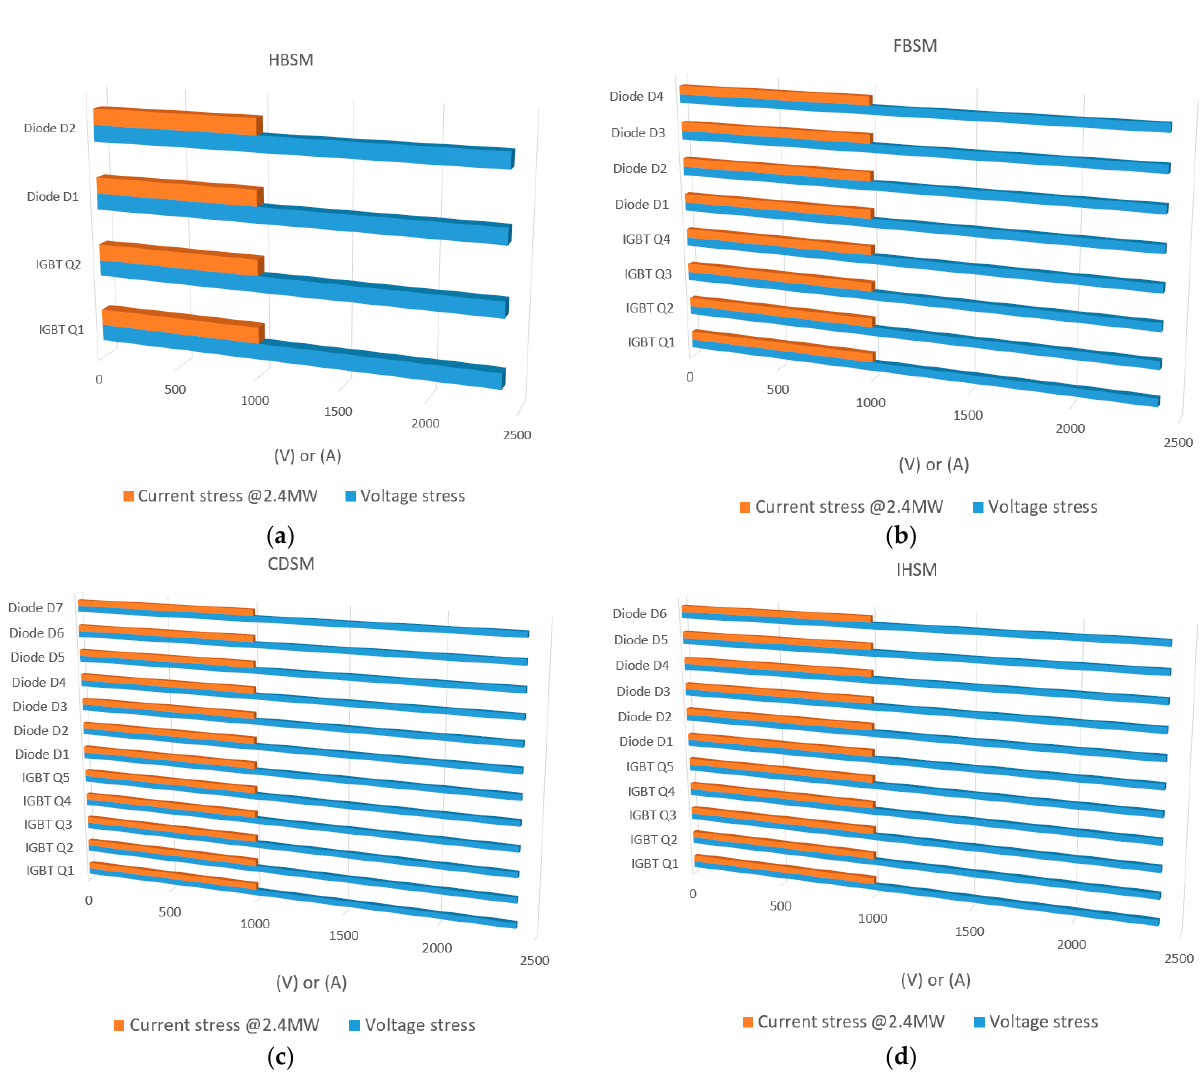
Figure 22. Comparison of voltage and current stress on the switching devices, ( a ) half-bridge submodule (HBSM), ( b ) full-bridge submodule (FBSM), ( c ) clamped-double submodule (CDSM), ( d ) improved hybrid submodule (IHSM).